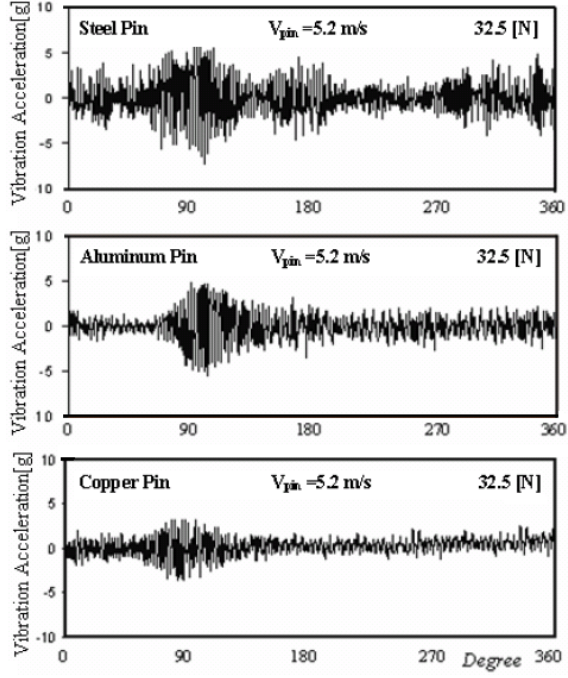
Fig. 3. Effect of varying the contacting pin on the vertical vibration of the disk at pin velocity of 5.2 m/s and 32.5 N normal